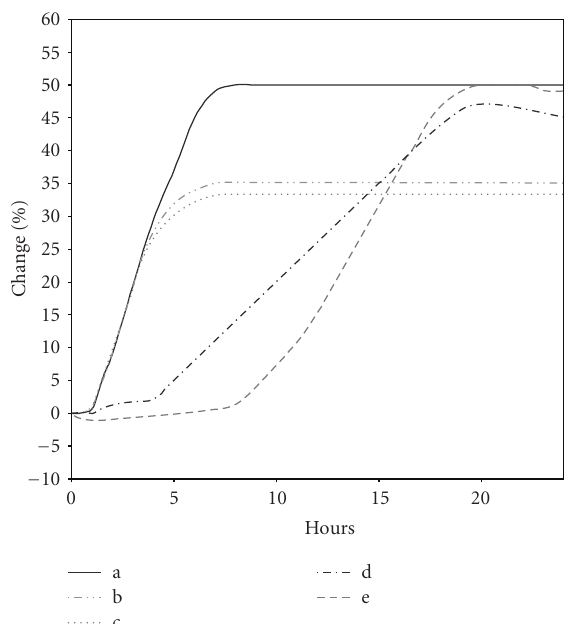
Figure 2: E ff ect of cell : phage ratio on the detection times and percentage change of conductance of 2/2 bacteriophage host S1400/94. These values were obtained from three experiments, in duplicate. Cell : phage ratio—(a) 1 : 0; (b) 1 : 0 . 1; (c) 1 : 1; (d) 1 : 10; (e) 1 :